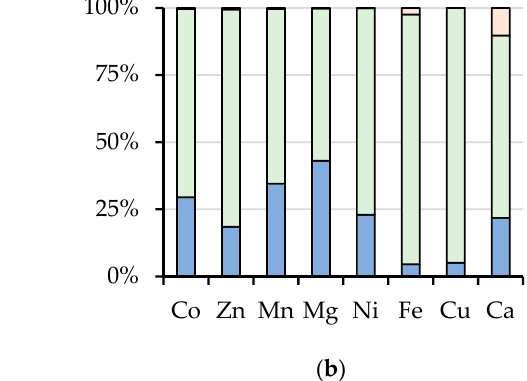
Table 3. The content of elements in geochemical fractions.